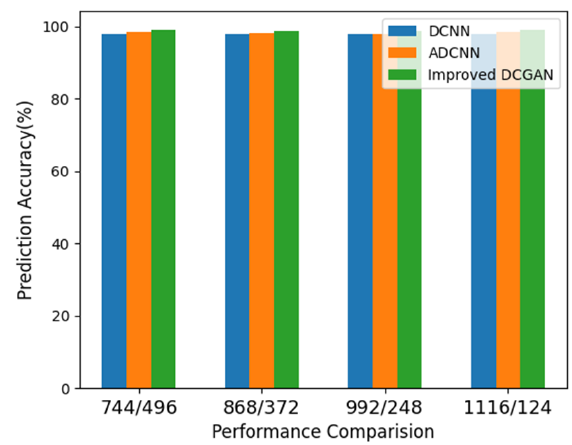
Figure 18. The performance of the different methods.